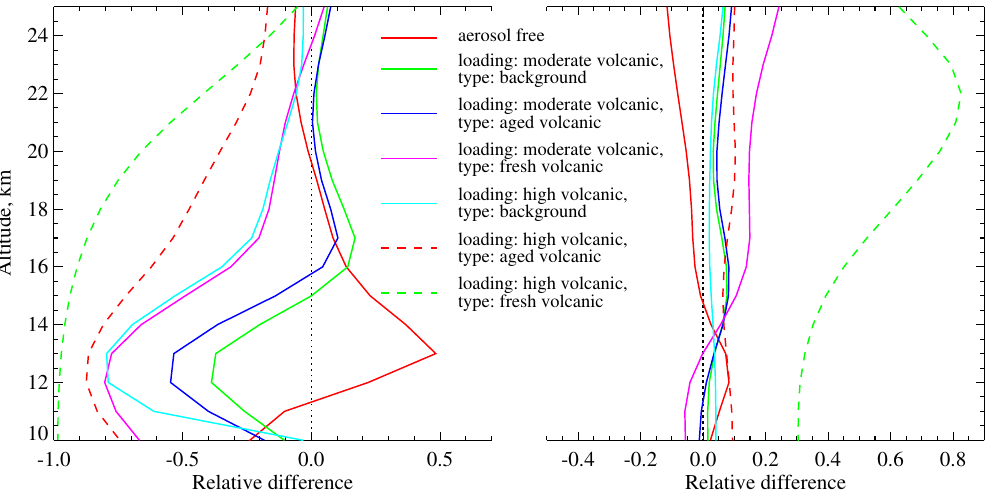
Fig. 15. Same as Fig. 14 but for an observation at high latitudes of the Northern